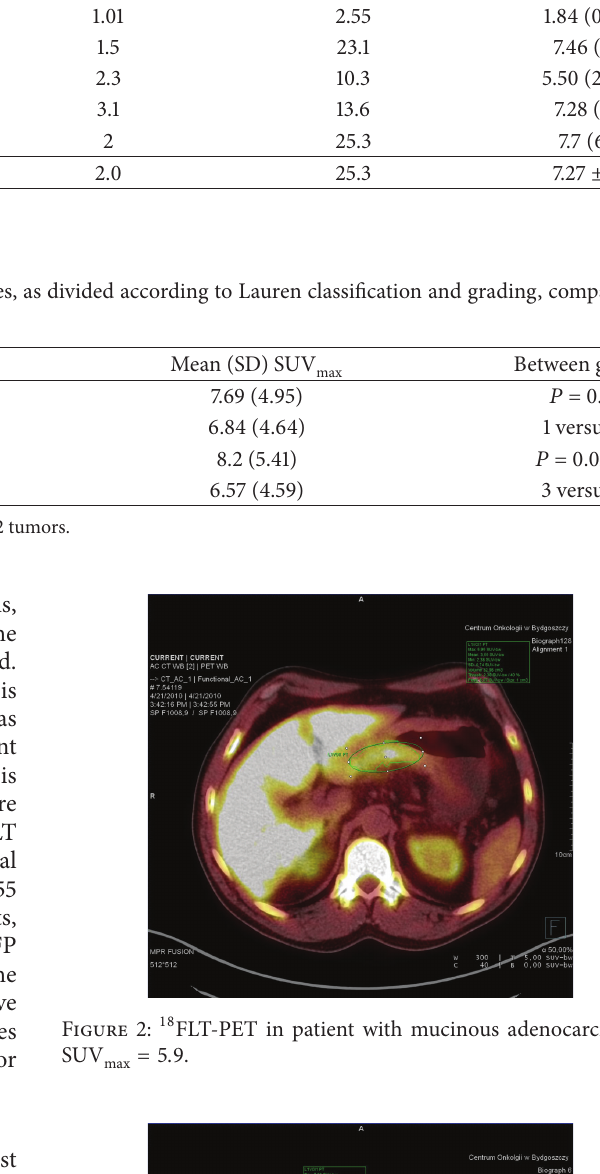
Table 2: The mean value of SUV